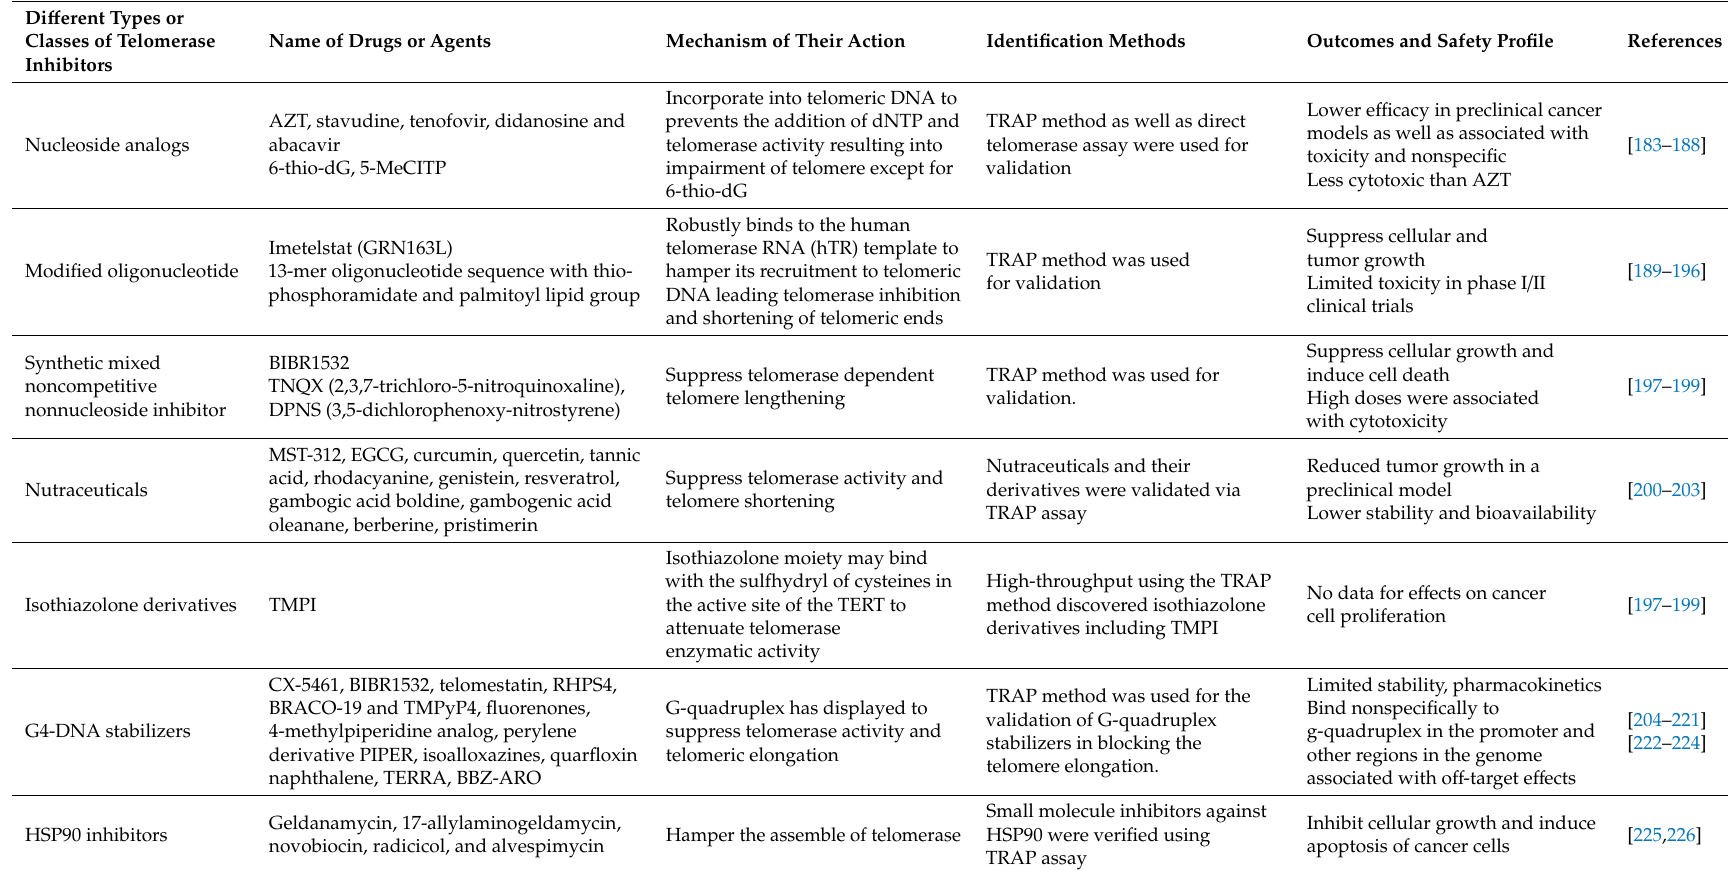
Table 2. Several types or classes of telomerase inhibitors and their